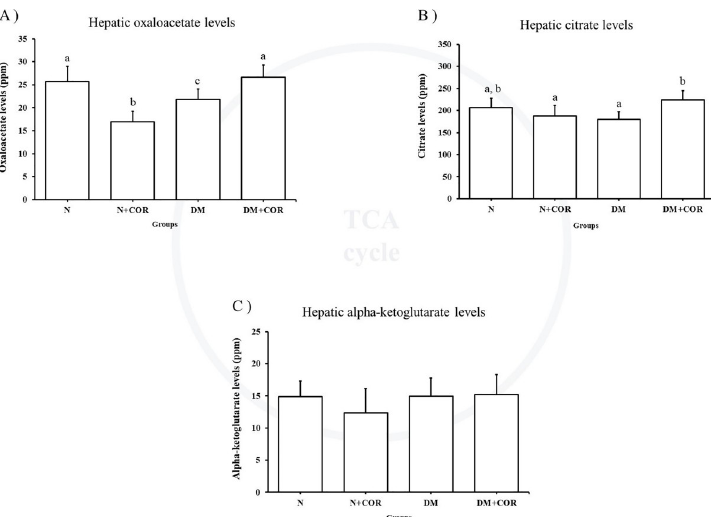
Fig 3. The level of (A) oxaloacetate, (B) citrate, and (C) alpha-ketoglutarate in liver tissues. Values are expressed as means ± SD. Different letters indicate statistically significant differences between groups ( P <